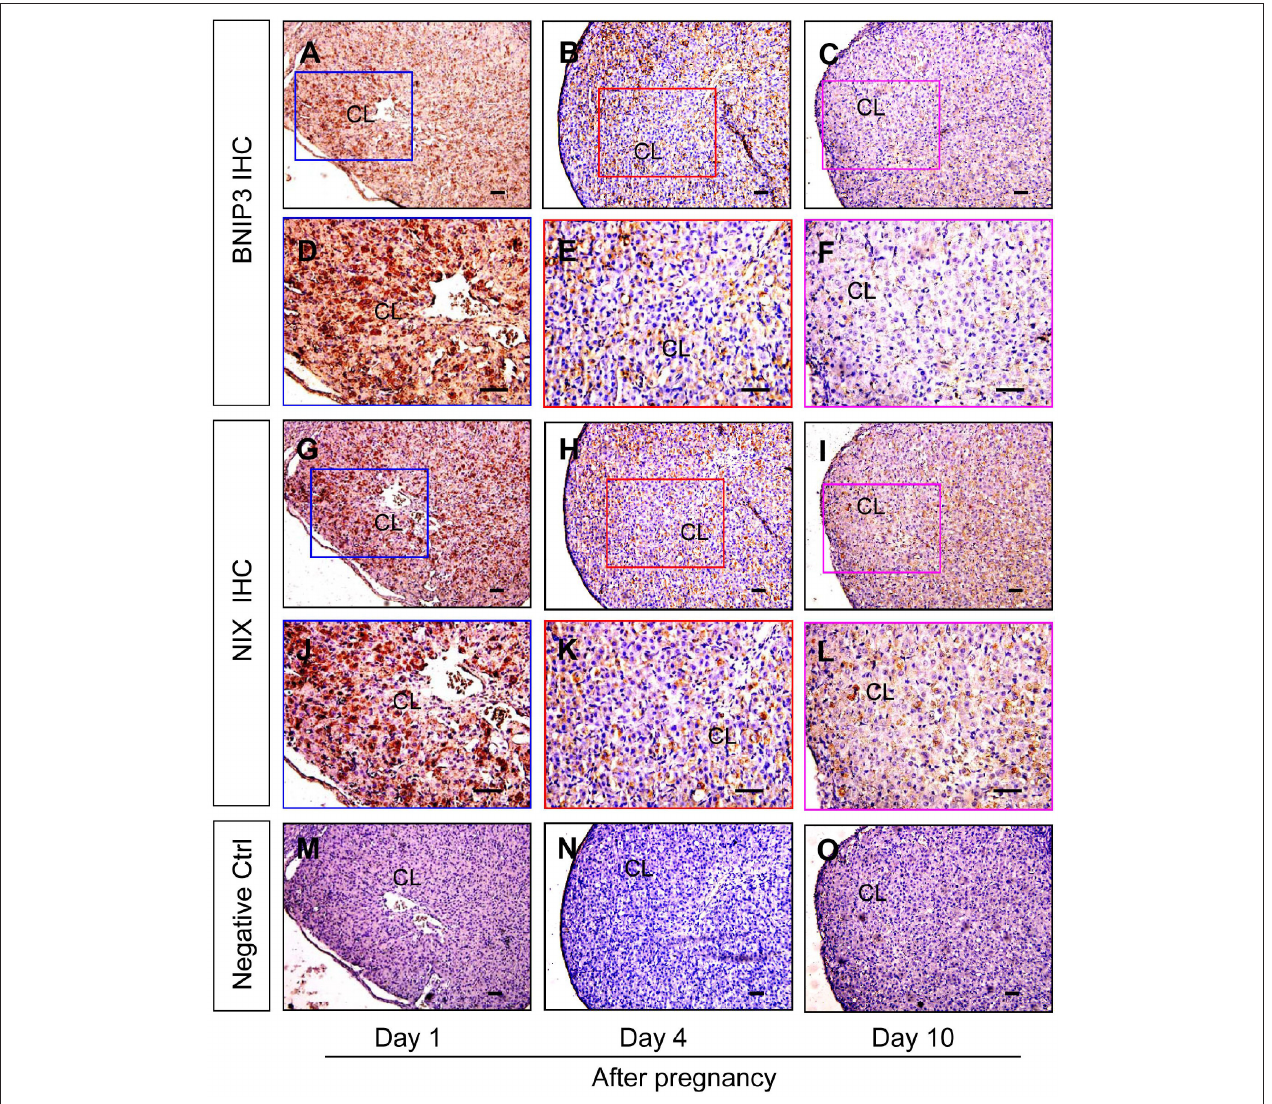
FIGURE 9 | Immunohistochemical staining of BNIP3/NIX during the development of corpus luteum. Three time points (Day 1, 4, and 10 after pregnancy) were selected and represented as the developmental process of corpus luteum according to our previous reports. Ovarian sections of each point ( A,D,G,J,M for Day 1; B,E,H,K,N for Day 4; C,F,I,L,O for Day 10) were immunostained for BNIP3/NIX and counterstained with hematoxylin. The BNIP3/NIX immunohistochemical signals appear brown, and the background counterstaining appears blue ( A–F for BNIP3 and G–L for NIX). Negative control remained unstained, lacking primary antibody instead of serum (M–O) . CL, corpus luteum, bar = 100 µ